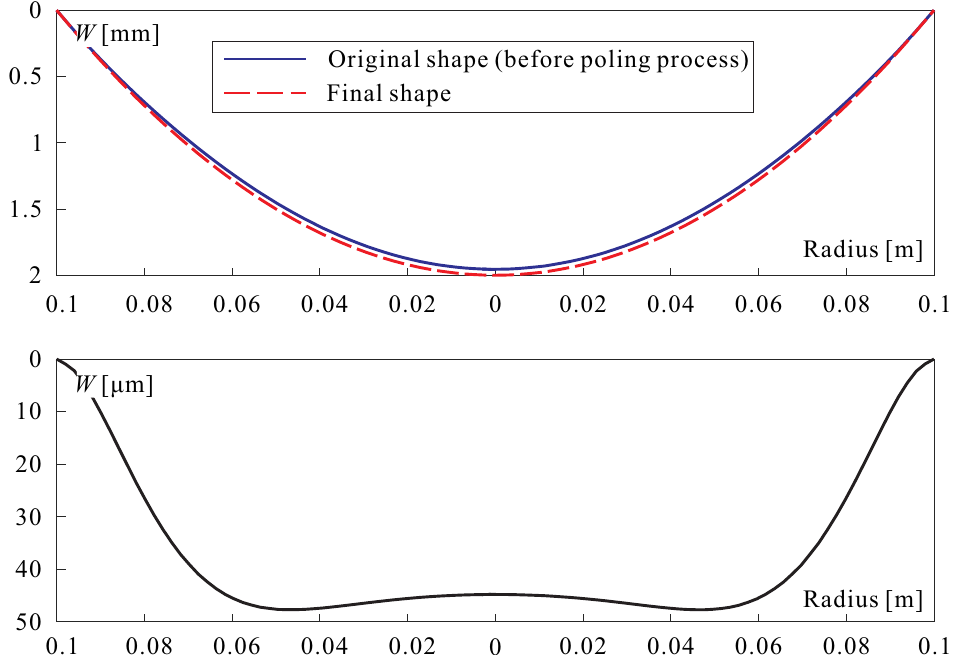
Figure 12. ( Top ): Original shape before poling and final shape. ( Bottom ): Shape deformation due to the poling